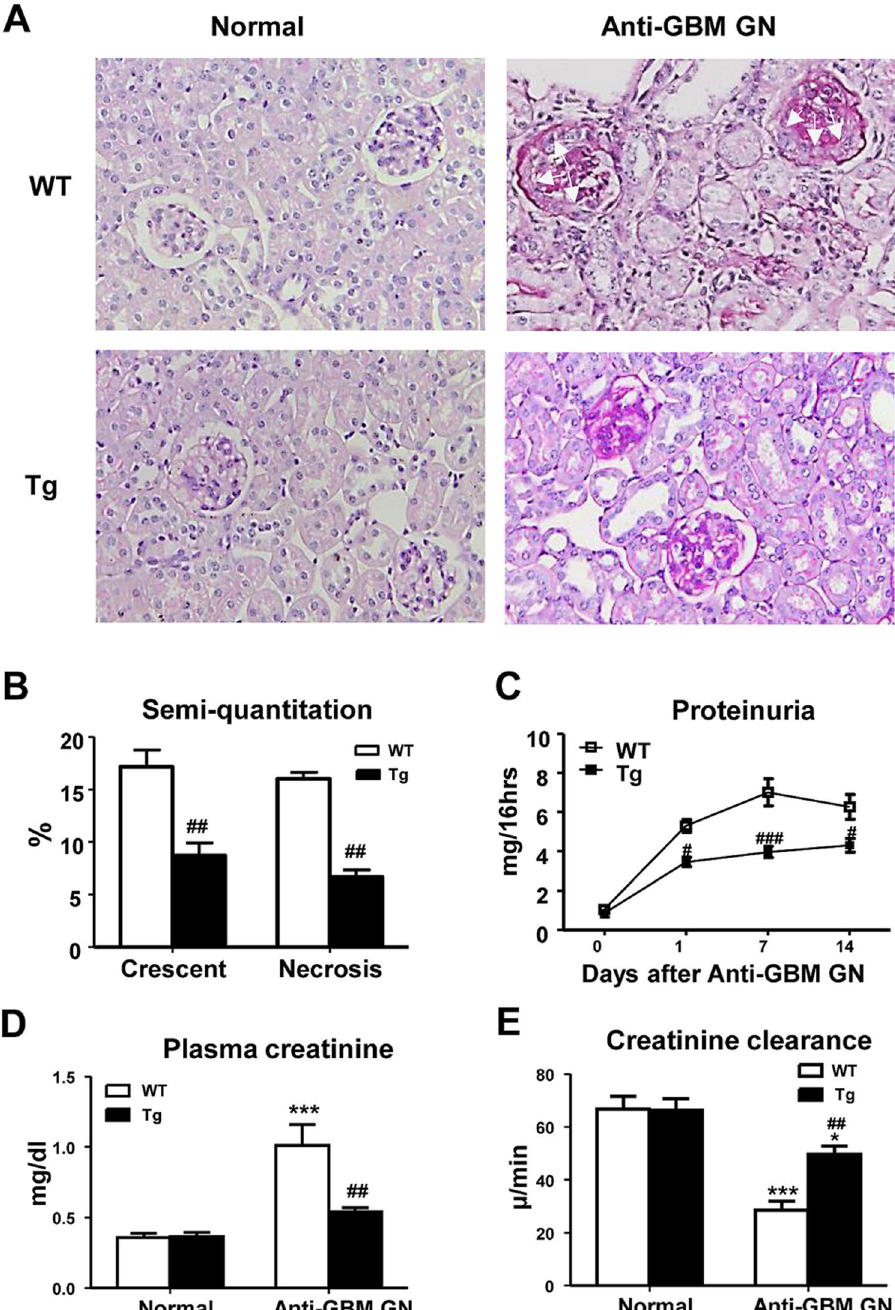
Figure 1. Foxp3 protects from functional and histological kidney injury in anti-GBM GN. ( A ) Representative histology sections stained with PAS. Compared with WT normal mouse kidney, severe glomerular crescent formation, segmental glomerular necrosis and tubulointerstitial damage are evident on Day 14 of anti-GBM disease in WT mice. In contrast, histological damage was substantially ameliorated in Foxp3 Tg mice with anti- GBM disease. Glomerular crescents are indicated by arrows. ( B ) Semi-quantitative analysis of histology. ( C ) Urinary protein excretion. ( D ) Plasma creatinine. ( E ) Creatinine clearance. Each bar represents mean ± SEM. * p < 0.05 and *** p < 0.001 compared with normal mice; # p < 0.05, ## p < 0.01 and ### p < 0.001 compared with the WT mice. n = 6–8 mice per group. Original magnification X200 ( A